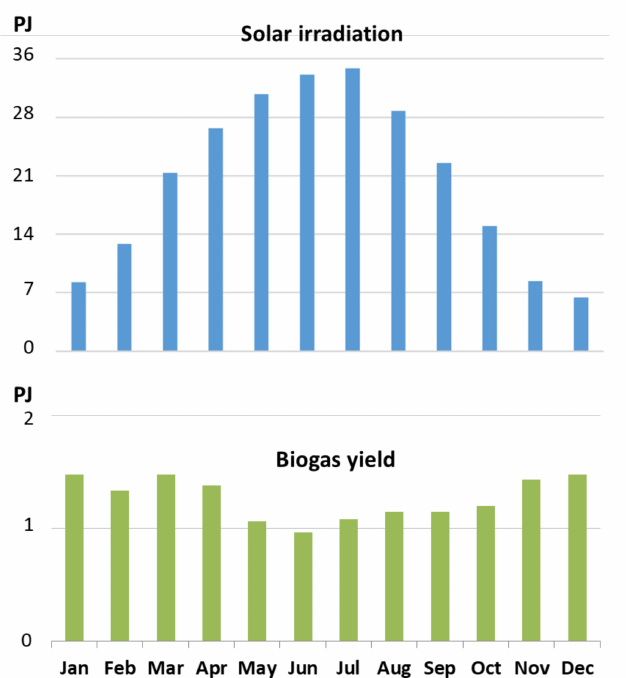
Figure 5. Monthly distribution of the agri-technical potentials: solar irradiation (above) and biogas yield (below) in petajoule (PJ) per